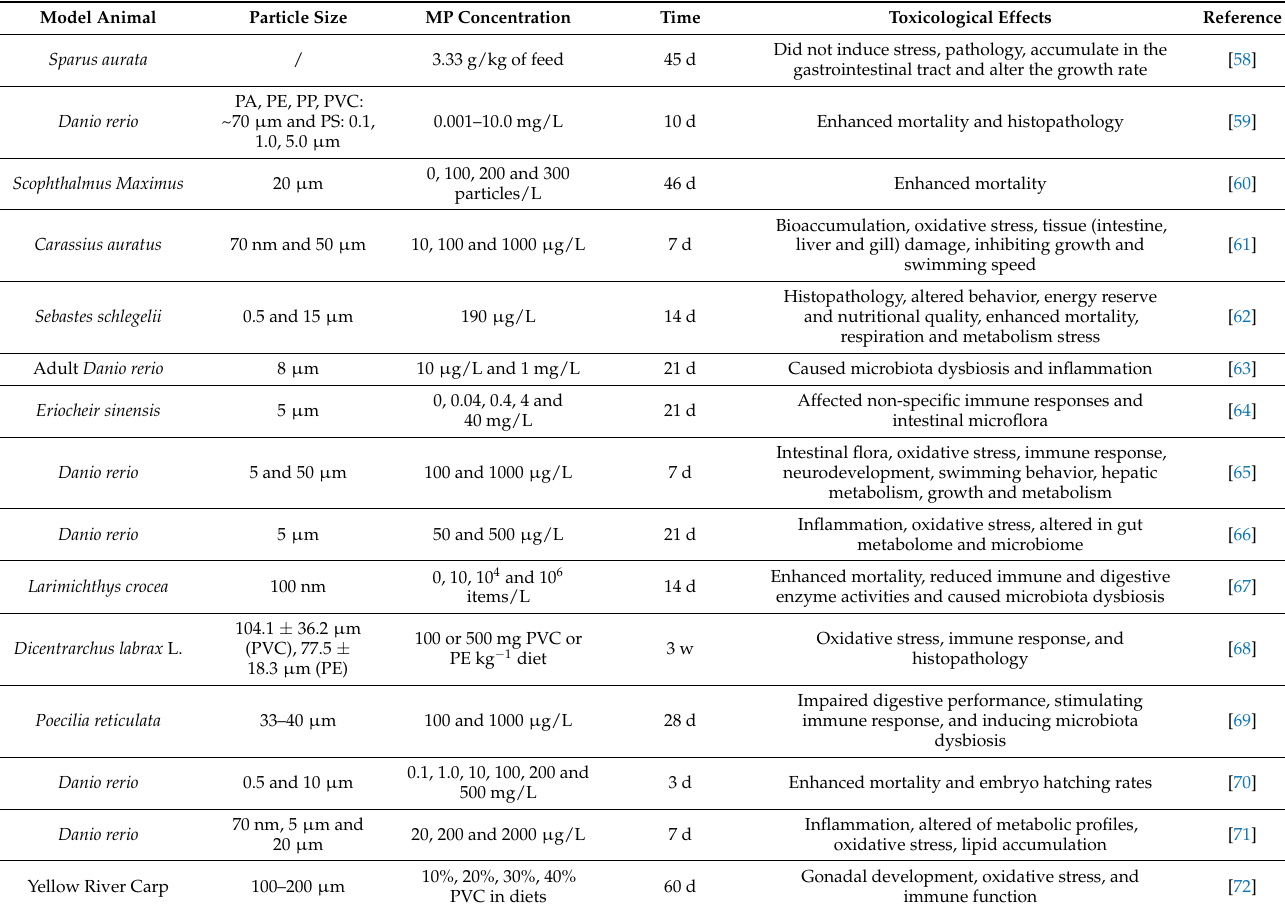
Table 3. The studies on stress responsiveness of MPs on aquatic animals in